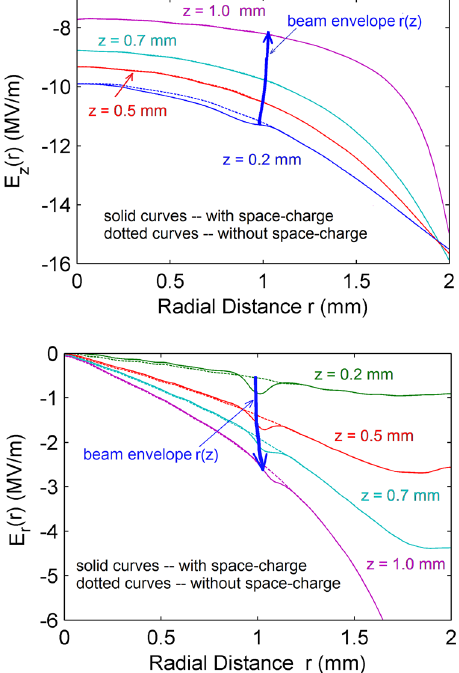
FIG. 15. A set of distributions of the longitudinal (upper plot) and transverse (bottom plot) electric field as function of the radial distance for different longitudinal positions. The solid curves depict solutions to the Poisson equation whereas the dotted curves are solutions to the Laplace equation. The beam envelope with the arrow pointing out the direction of increasing z is also